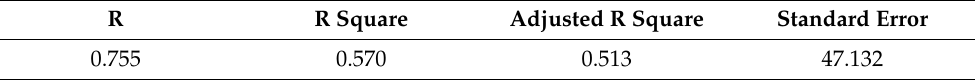
Table 4. R Square